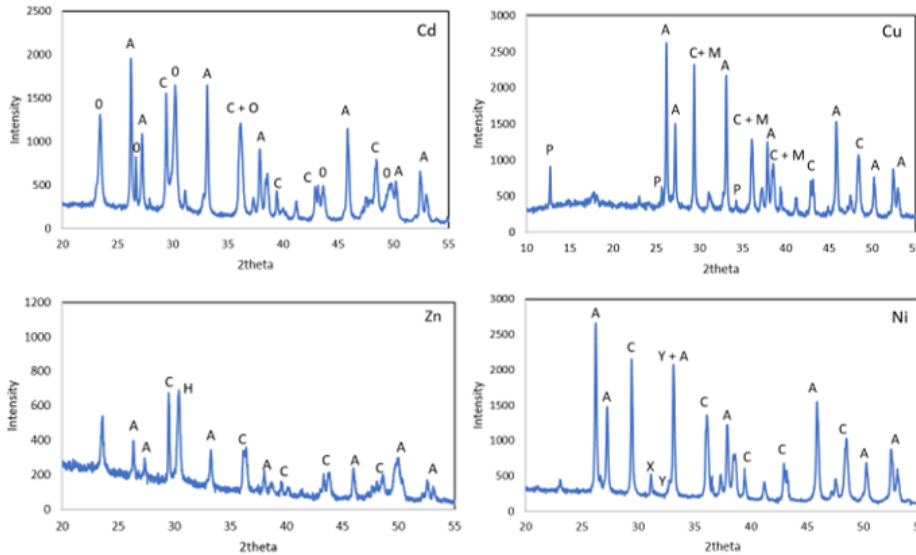
Figure 8. X-ray diffraction patterns of WS after treatment. O—otavite, P—posnjakite, M—malachite, H—hydrozincite, X—Ni 5 (CO 3 ) 4 (OH) 2 ·4.5H 2 O, Y—Ni 3 (CO 3 )(OH) 4 ·4H 2 O, A—aragonite and C—calcite.